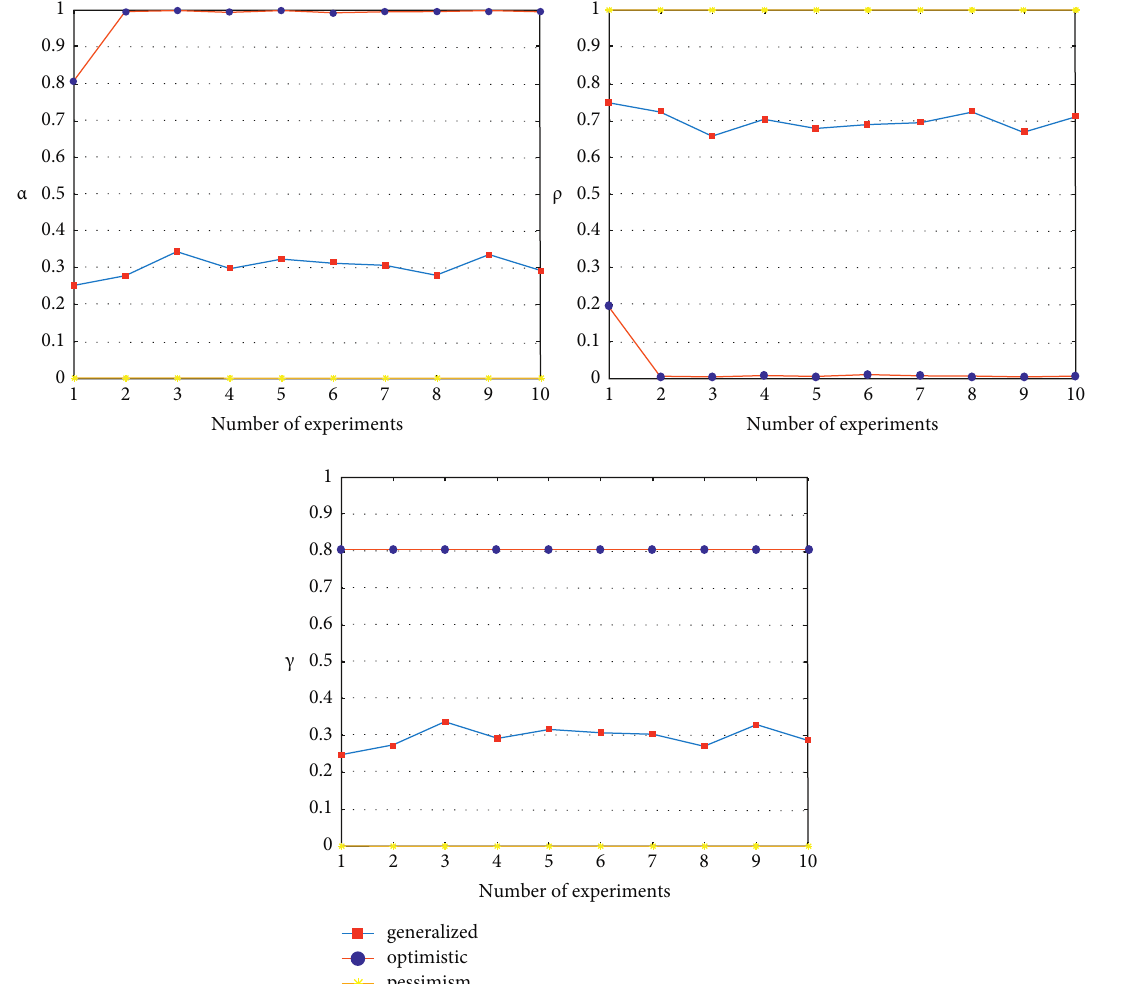
Figure 4: Uncertainty measurement of weighted multigranulation model for “own-data